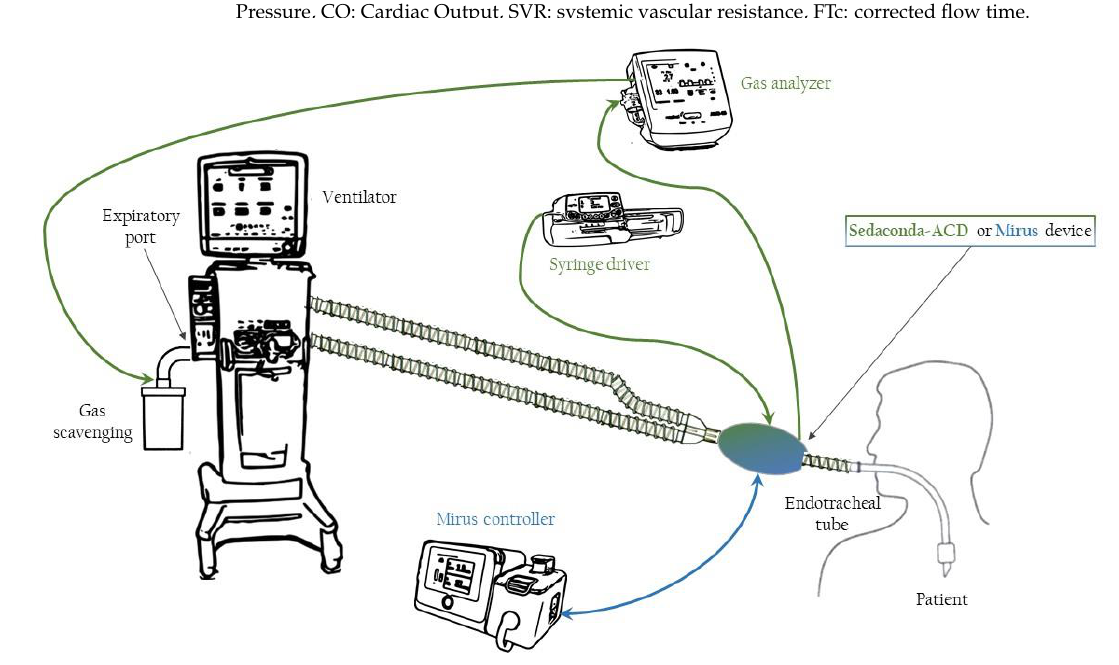
Figure 1. An Illustration of ICU setup for inhalation sedation. Reproduced with permission from Jabaudon M, et al. Anaesth Crit Care Pain Med. 2022. [25].